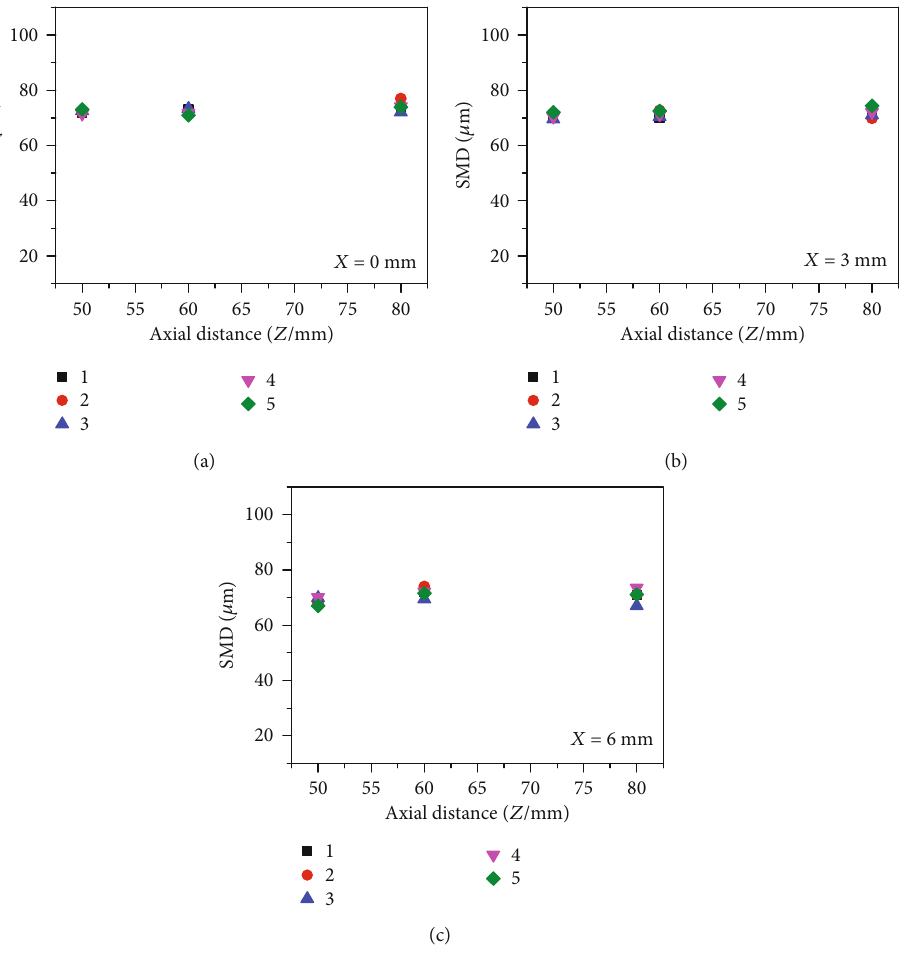
Figure 6: The accuracy of SMD obtained by the repetitive measurement measured at ALR = 1 : 24 . Table 3: The uncertainty in